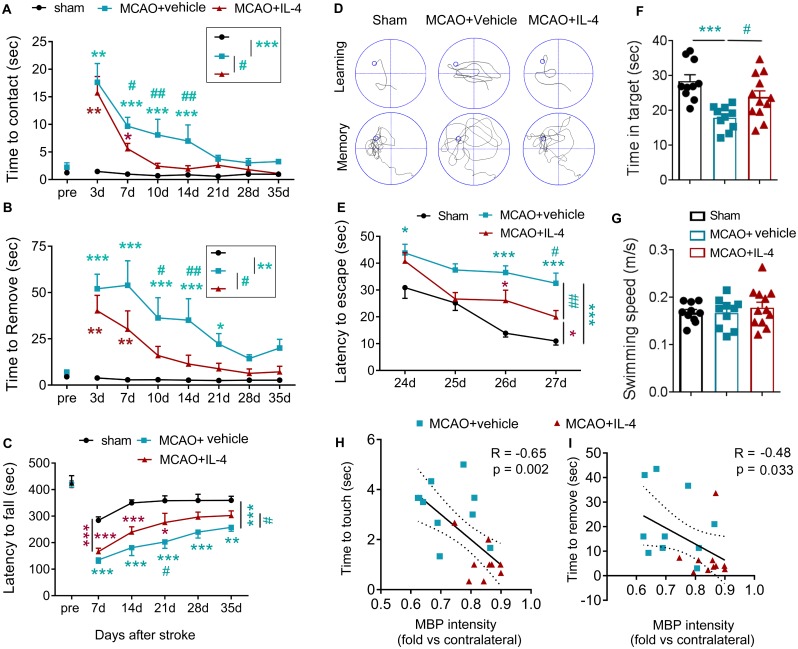
Poststroke administration of IL-4 improves long-term neurological functions after MCAO.Mice received intranasal infusions of IL-4 (50 μg/kg) or vehicle 6 h after 60-min MCAO and at daily intervals on days 1–7 and then every 7 d until 28 d after stroke. (A-C) Sensorimotor functions were assessed up to 35 d after MCAO or sham operation. (A-B) Adhesive removal test. The latencies to contact (A) and remove (B) the tapes were recorded. n = 10–14/group. (C) Rotarod test. The latency to fall or spin around on the rungs was quantified. n = 7–9/group. (D-G) Long-term cognitive functions were evaluated in the Morris water maze. Panel D shows representative images of the swim paths of mice in each group while the platform was present (learning phase) or removed (memory phase). IL-4-treated mice showed improved cognitive functions, as reflected by shorter escape times (E, learning), and extension of the time spent in the target quadrant (F, memory) with no change in swim speed (G). n = 10–12/group. *p < 0.05, **p < 0.01, ***p < 0.001, versus sham or as indicated. #p < 0.05, ##p < 0.01, ###p < 0.001 MCAO+IL-4 versus MCAO+vehicle or as indicated. Two-way ANOVA repeated measurement or one-way ANOVA and Bonferroni post hoc. (H-I) Spearman correlation between MBP intensity at 35 d after MCAO and average latency to contact or remove adhesive tape from the lesioned forelimb at 35 d after MCAO. Data associated with this figure can be found in the supplemental data file (S1 Data). IL-4, interleukin-4; MBP, myelin basic protein; MCAO, middle cerebral artery occlusion.